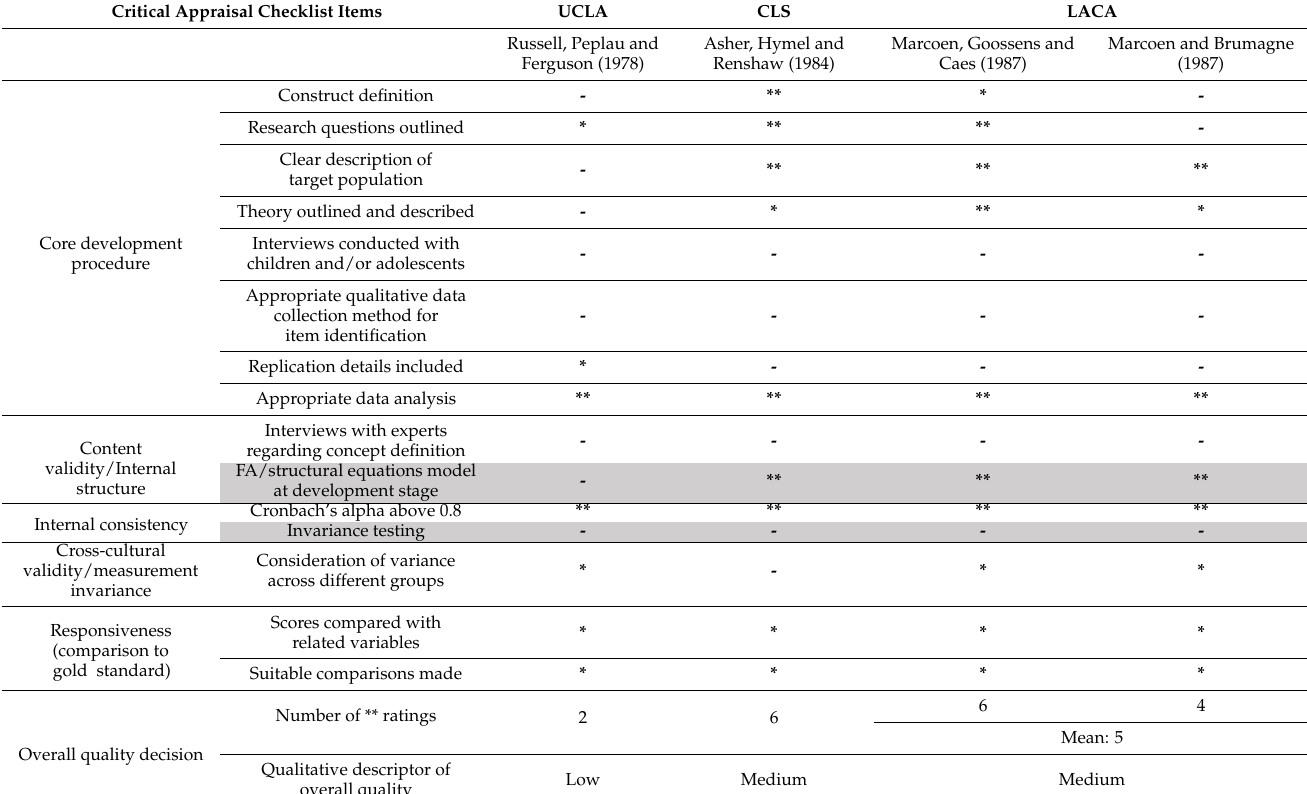
Table 1. Critical appraisal checklist ratings for each development